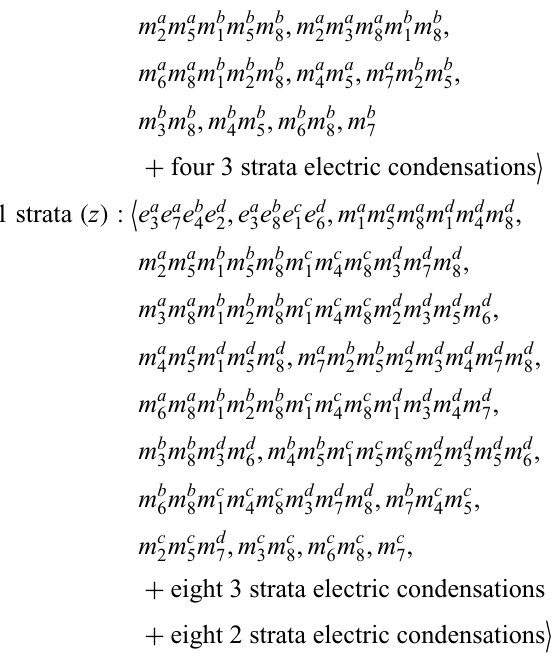
that condenses on the e a e b e d 7 3 4 2